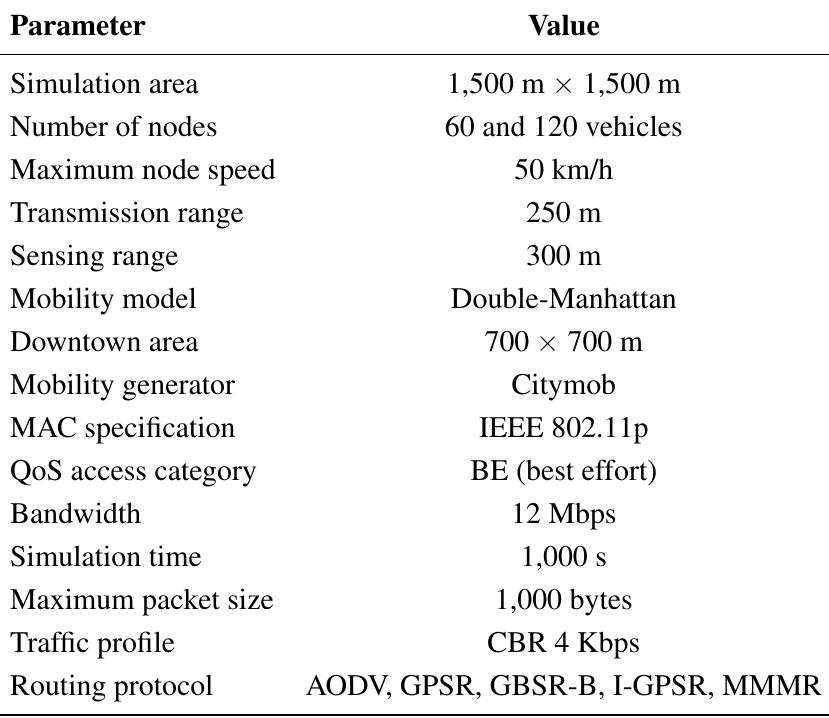
Table 4. The main simulation settings used in the evaluation